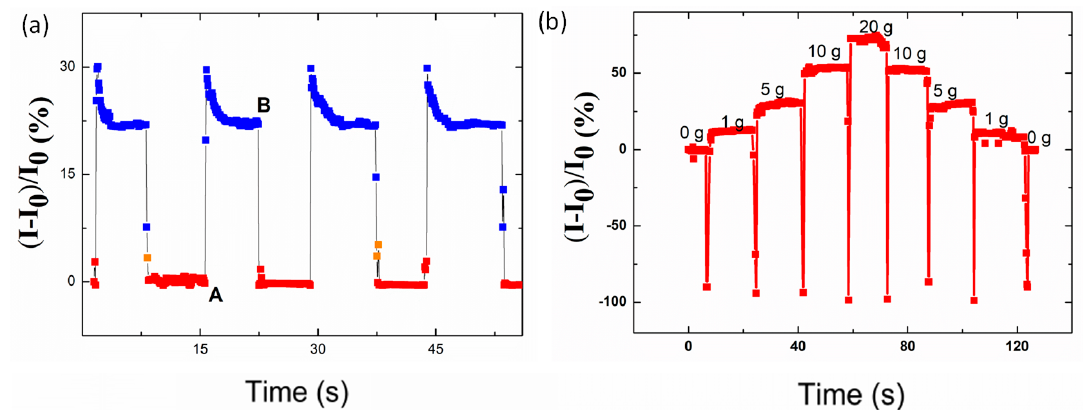
Figure 12. ( a ) Current response of the sensor to the tapping of the finger. A: The relaxing state of the strain sensor at the point the pressure was assessed by the index finger. B: Thetransition point from a pressure state to a relaxed state when a tapping was withdrawn suddenly. ( b ) Current response of the sensor to the various weights.